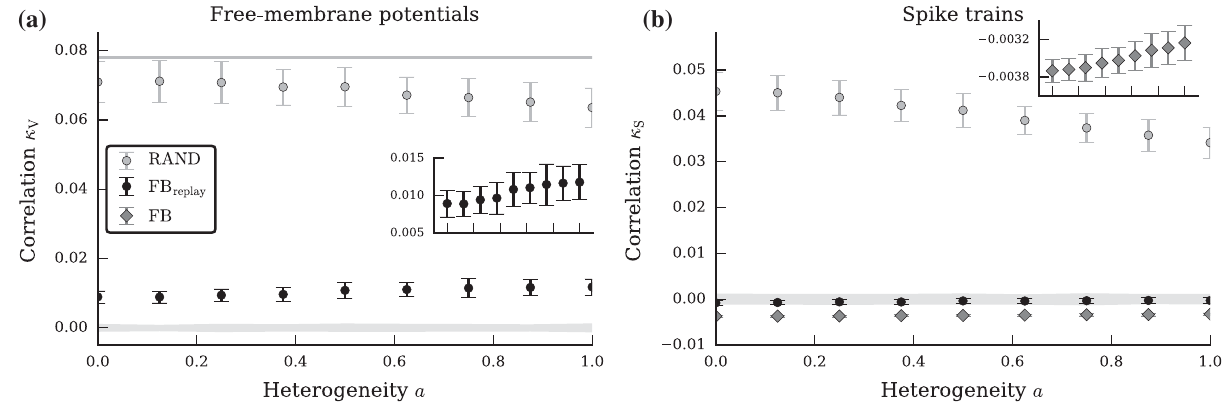
FIG. 8. Dependence of population-averaged input correlations (a) and spike-train correlations (b) on the heterogeneity of the neuromorphic substrate for the intact network (FB, dark gray diamonds), the FB (black circles), and the RAND (light gray circles) replay cases. Symbols and error bars denote mean and 1 standard deviation, respectively, across M ¼ 100 network realizations (error bars are partly covered by markers). The gray line in (a) depicts shared-input correlations in a homogeneous network [Eq. (2)]. Insets in (a) and (b) depict magnified views of input correlations in the FB case and spike-train correlations in the FB case, respectively. replay The light gray horizontal band represents mean (cid:3) 3 standard deviations of (spurious) correlations in surrogate data where corre- lations were removed. Note that free membrane potentials cannot be recorded in the FB case (see Sec. II). Hence, there are no gray diamonds in